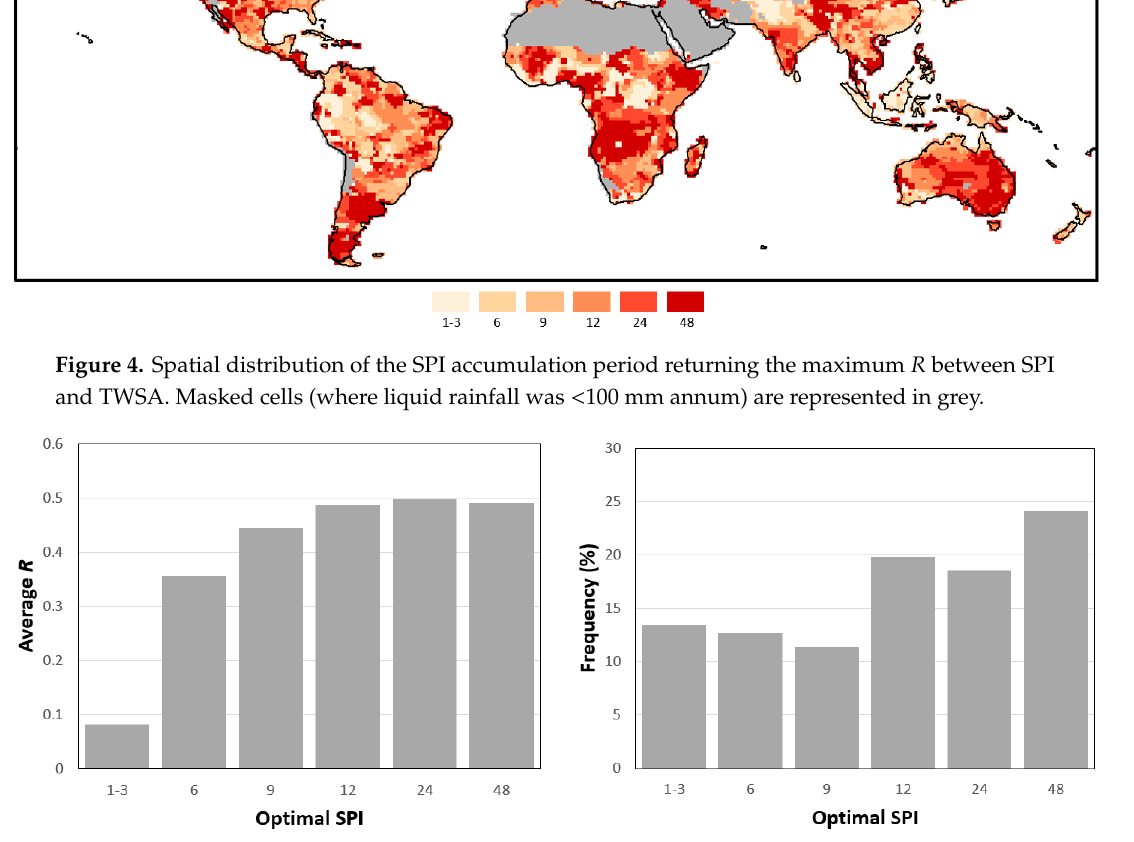
( b ) Figure 5. Statistics of the optimal SPI. ( a ) Average R values for all the cells with the same local-optimal SPI value. ( b ) Frequency distribution of the local-optimal SPI values at the global scale.